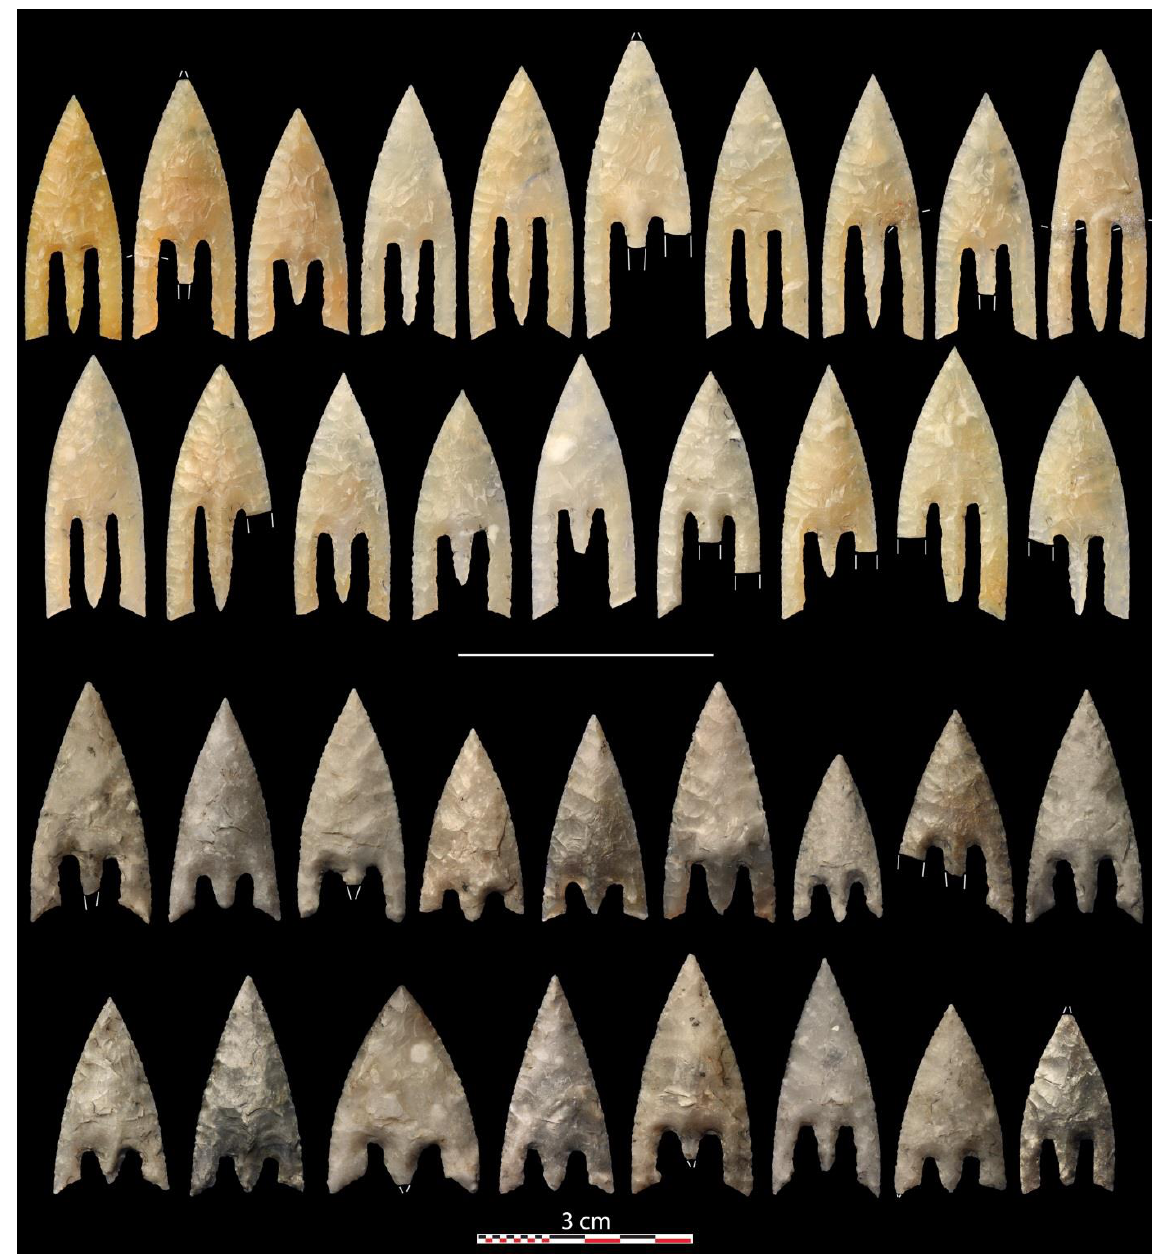
Figure 7. Arrowheads from the Limbabu grave at Saint-Thégonnec, Finistère (top) and from the Lescongar barrow at Plouhinec, Finistère (bottom) (photo C.